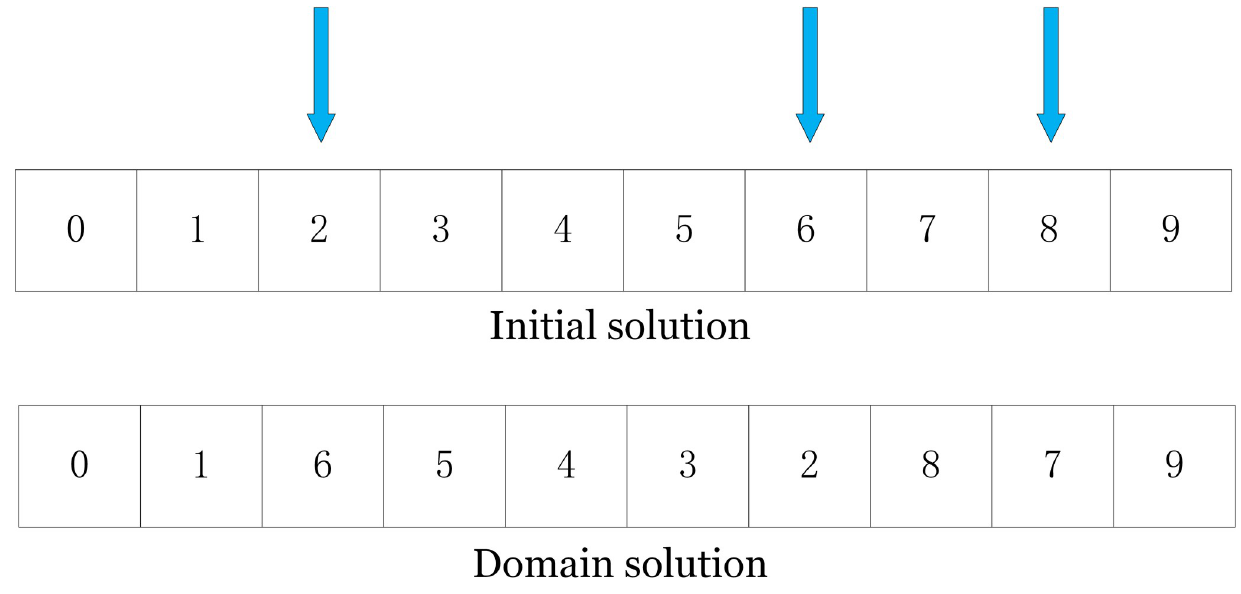
Fig 8. 3-opt example